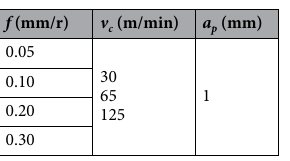
Table 2. Cutting parameters for dry turning tests.